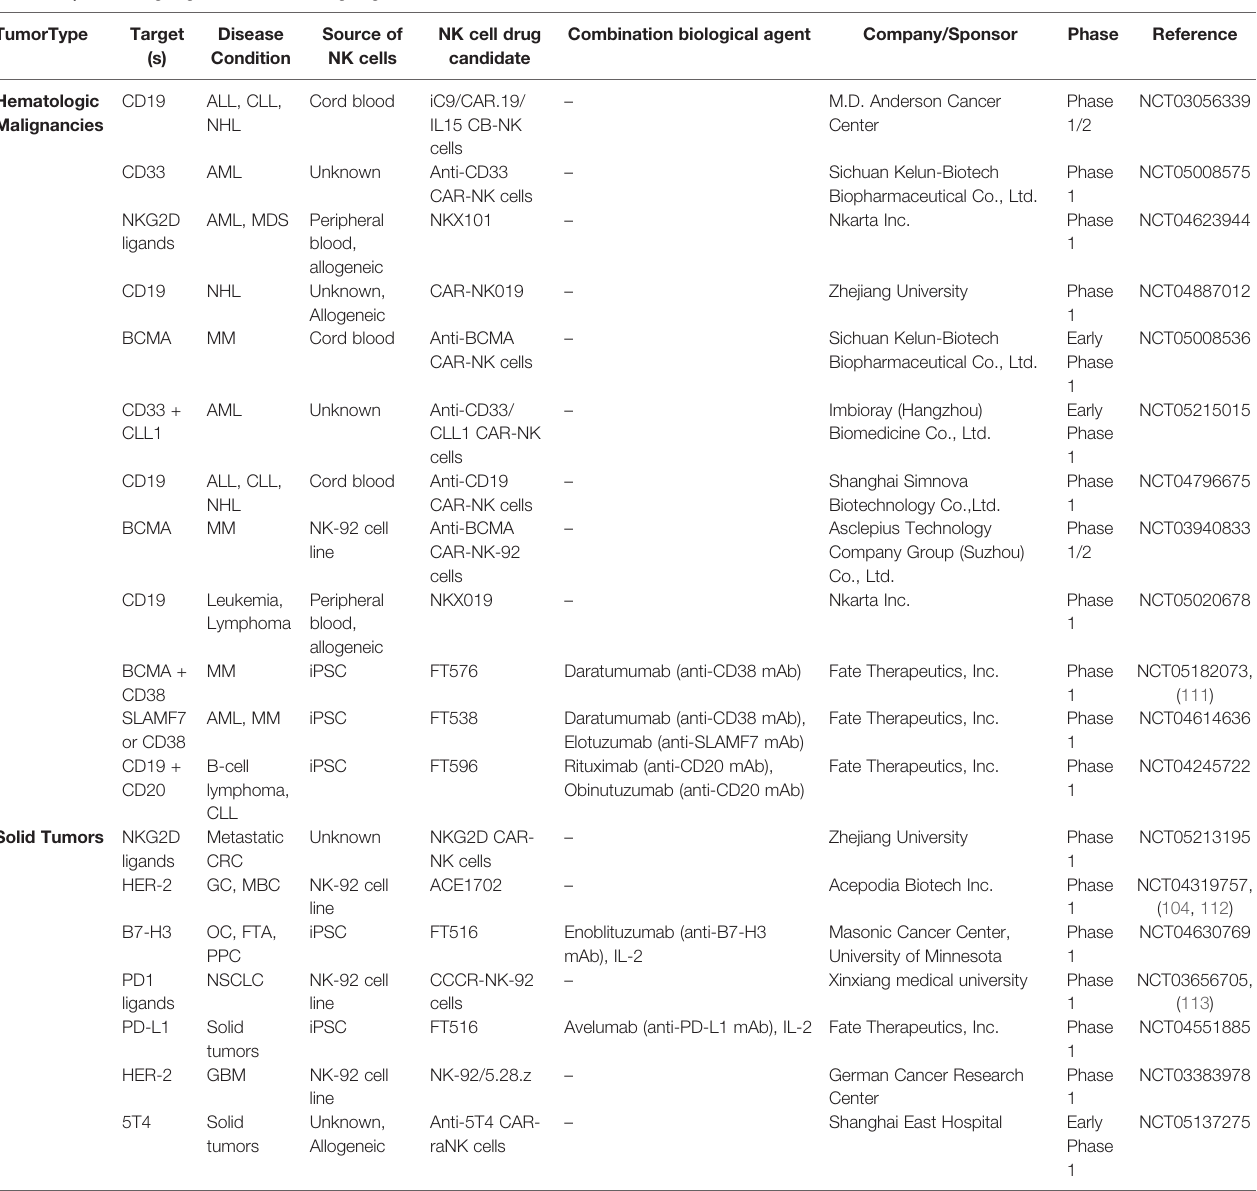
TABLE 2 | List of ongoing clinical trials utilizing engineered NK